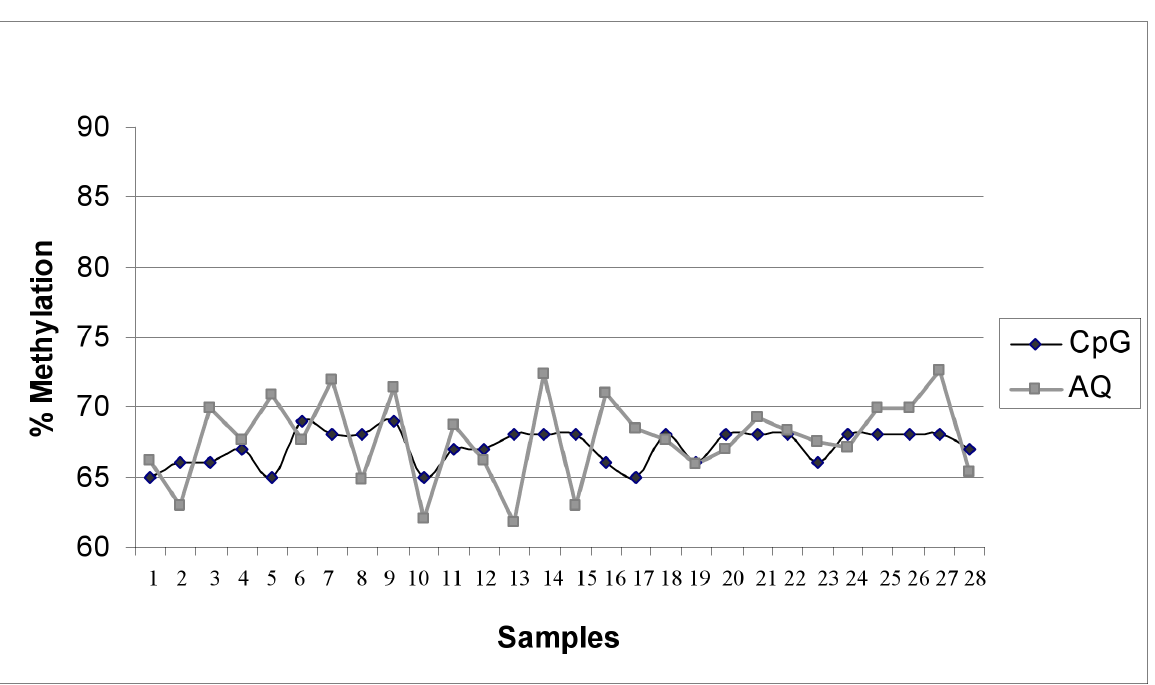
Fig 3. LINE-1 methylation analysis of DNA samples (DD study) tested in duplicate onto. PyroMark CpG mode and AQ mode. DNA samples (N = 28) obtained from buffy coats of patients involved in “ DD study ” [25]. Mean methylation percentage of 6 CpGs in the promoter of LINE-1 gene is reported. Target sequence: 108 bp of LINE-1 (GeneBank X58075.1 at position 117 – 224); CpGs at position 156, 131, 165, 167, 172, 182. Deviation between paired samples ranged from 0.5 to 4.2%. No red scores were assigned by the AQ mode. CpG mode assigned blue score only to the first CpG of each sample: all the other CpG in each samples received red or yellow scores.